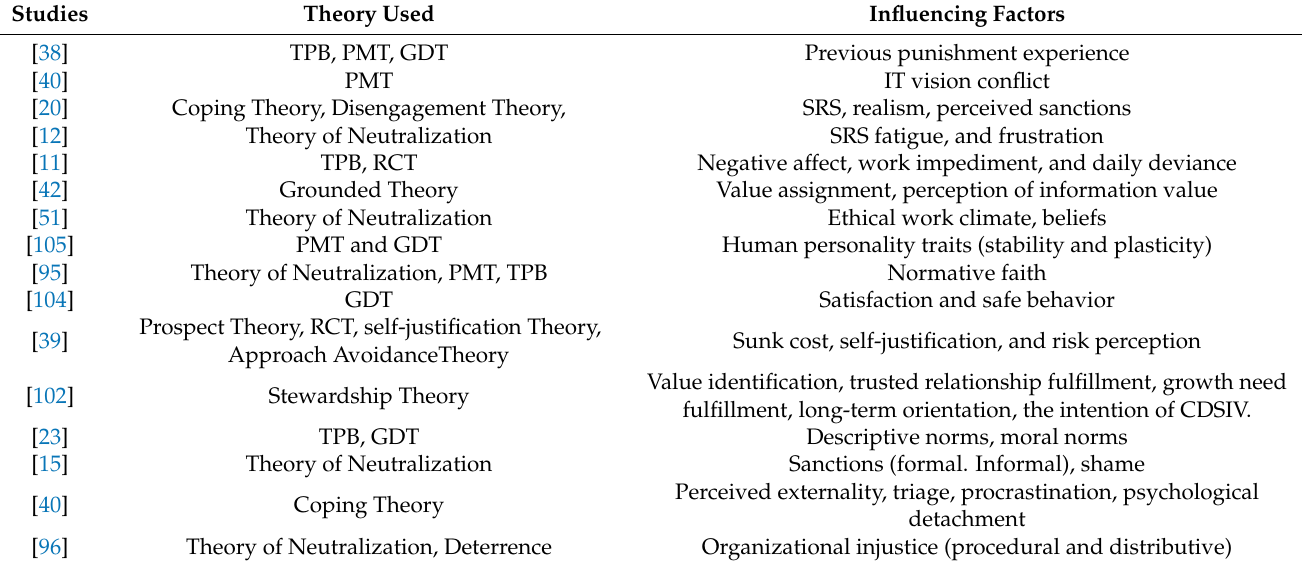
Table A2. Overview of factors influencing compliance.